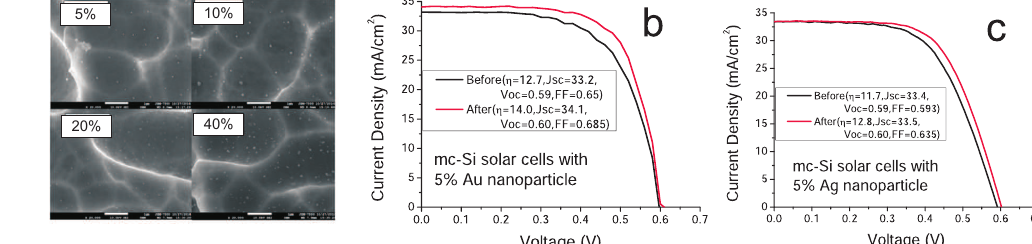
Figure 7. ( a ) EM photography [3] of distribution of metallic nanoparticles (Au) on the surface of the multi-crystalline Si solar cell—very low surface concentration of metallic components is visible (percentage refers to concentration of colloidal solution used for spin coating of a cell surface). ( b,c ) comparison of solar cell efficiency due to plasmon modification of the multi-crystal Si solar cell expressed by an increase of the area in the figure beneath the red I–V curve with respect to the area ranged by the black curve, ( b ) with Au nanoparticles (efficiency increase is ca. 6.5%), ( c ) by Ag nanoparticles (efficiency increase is ca. 2.5%), acc. to our study [3]. The significant difference in I–V characteristic for metallized Si and perovskite cells is noticeable—compare Figure 6c—which corresponds to different mechanism of plasmon induced efficiency increase, by strengthening of the photo-current due to easier dissociation of excitons in metallized perovskite